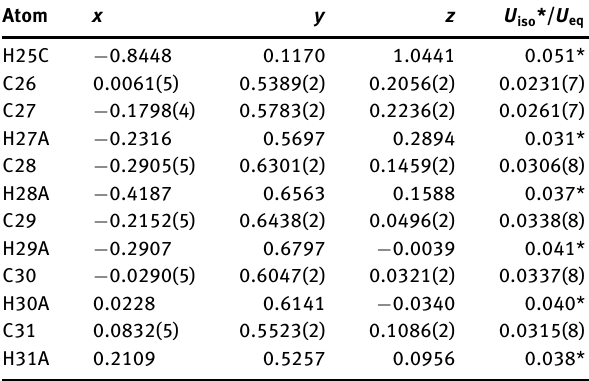
Table 2: Fractional atomic coordinates and isotropic or equivalent isotropic displacement parameters (Å 2